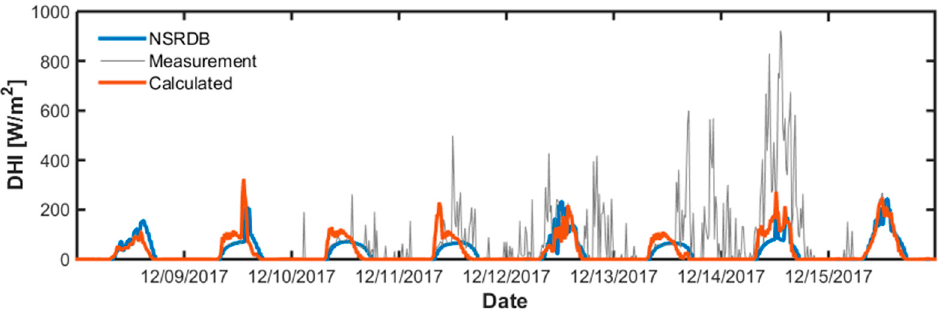
Figure 5. Difference between measured and calculated diffuse horizontal irradiance (DHI). Figure 5. Di ff erence between measured and calculated di ff use horizontal irradiance